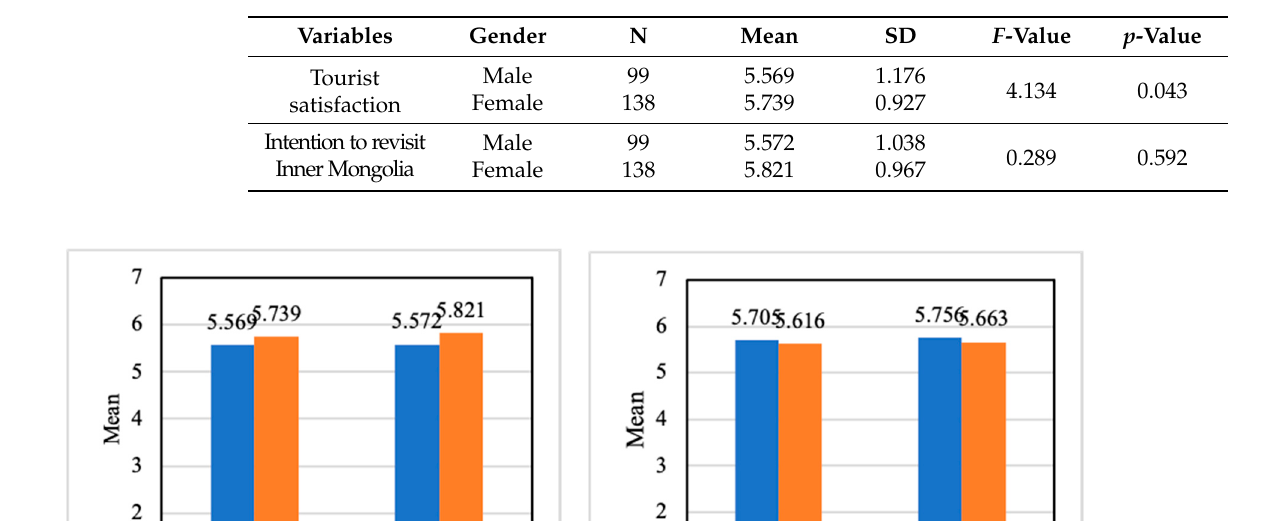
Table 5. Gender differences in tourist satisfaction and Intention to revisit Inner Mongolia.